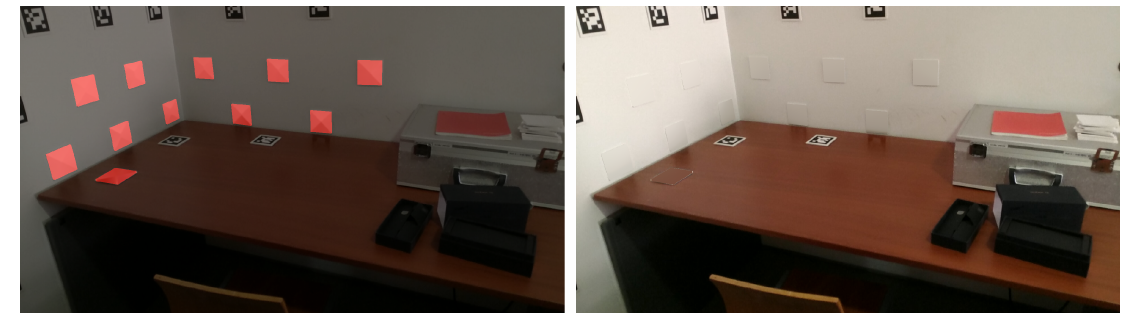
Figure 9. Example dataset image restoration attempt: ( left ) mask for the pixels to be replaced; ( right ) results with blurring.